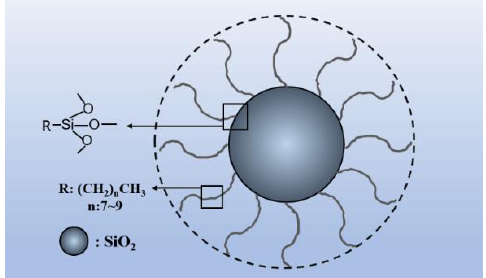
Figure 1. Schematic diagram of molecular structure of hybrid nanoSiO 2